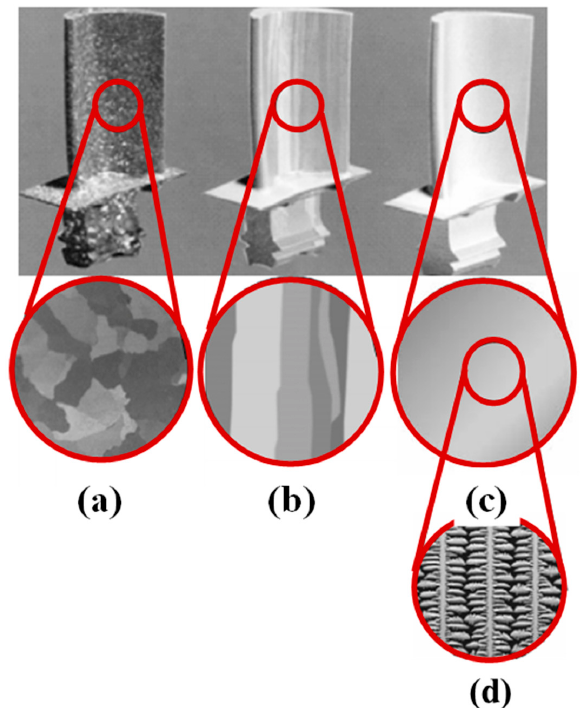
Figure 2. Representative images showing the ( a ) equiaxed, ( b ) directionally solidified, ( c ) single crystal microstructure. ( d ) Zoomed view of ( c ) illustrating the dendrite microstructure in single crystal turbine blades (Reproduced with permission from [5], Copyright 2008 by The Minerals, Metals and Materials Society).